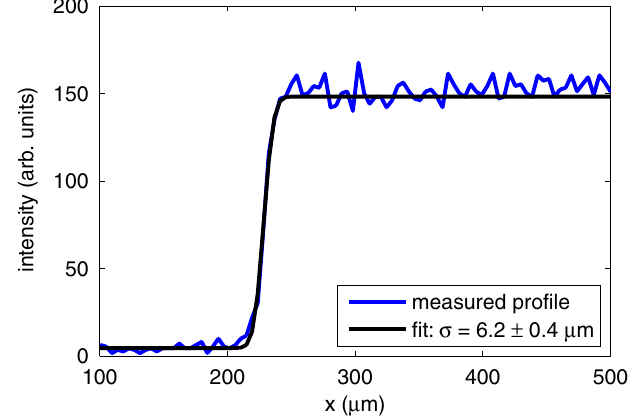
FIG. 13. (Color) Resolution of the x-ray camera with P43 screen, measured using the sharp edge from a tungsten bar in front of the screen. The rms resolution is (cid:1) camera (cid:2) 6 (cid:1) m . the 2.4 magnification, the measured electron beam size is 5 : 9 (cid:1) m . We also measured the beam size against the lifetime as shown in Fig. 15. The camera setup is the same as above. The measurement has been done in a short time so that the conditions are the same across a set of skew quadrupole values. The horizontal beam sizes in pinhole 1 and pinhole 2 were constant at nominal values, 50 and 48 (cid:1) m for pinhole 1 and pinhole 2, respectively. The curves are linearized with the quadratic correction, showing that the estimated resolution of the two systems is in agreement with the measurement. At a constant current, the linear behavior of the beam size vs lifetime is expected from a Touscheck lifetime limited beam. The slopes of the two corrected curves are 1.17 and 1 : 27 ð (cid:1) m = hour Þ , agreeing with each other within 8%.